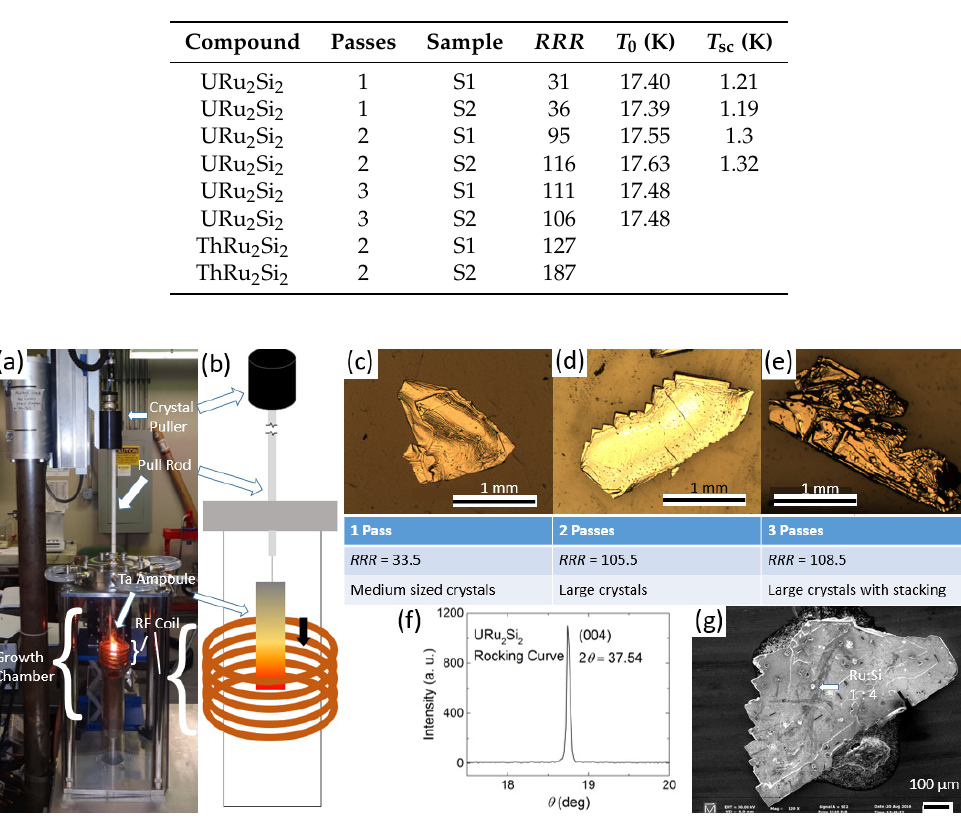
Table 1. Growth parameters and characteristics of two representative samples from each batch. Includes the number of times the sample was passed through the hot zone, the residual resistivity ratio RRR = ρ 300K / ρ 0 (where ρ 300K is the room temperature resistivity and ρ 0 is the extrapolated zero temperature resistivity), the hidden order temperature T 0 , and the superconducting transition temperature T sc . For the URu 2 Si 2 “two-pass" batch, we have measured ρ ( T ) for ten different samples (not shown). We find that RRR varies between 95–110, revealing consistent sample quality thoughout the batch.